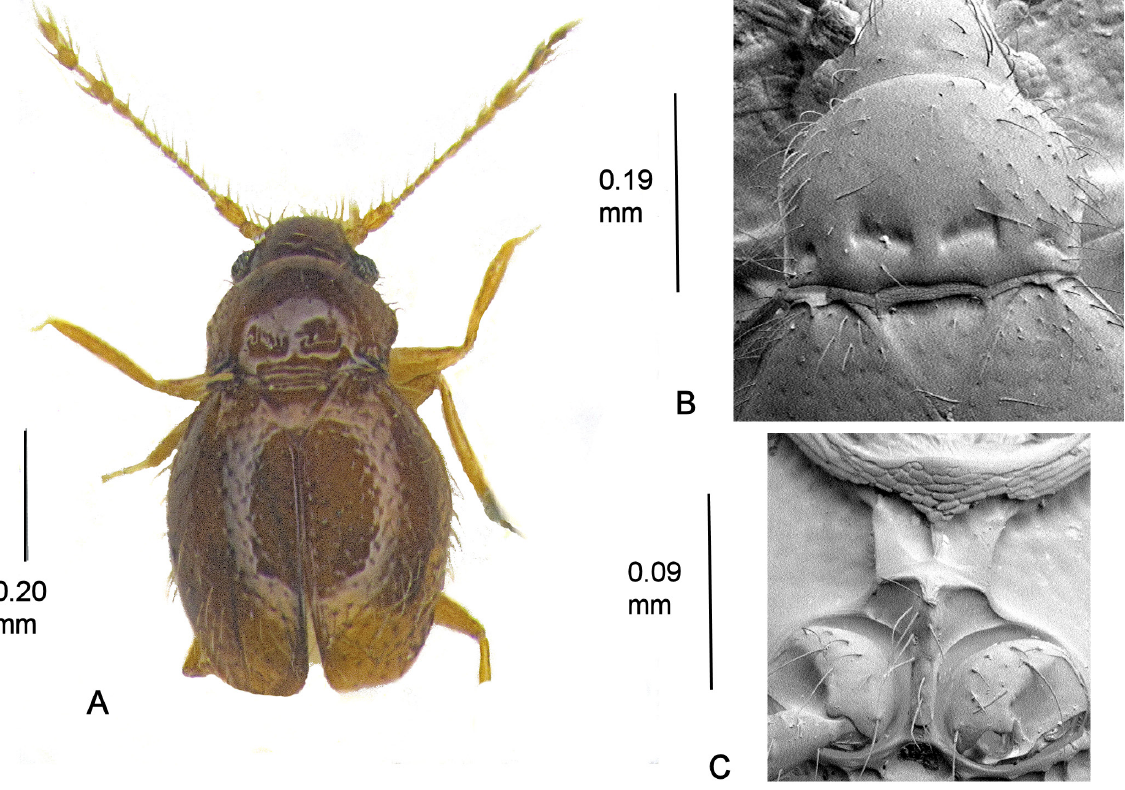
Fig. 18. Cissidium ceylonicum sp. nov. A . Habitus. B . Pronotum, × 590. C . Mesoventrite showing median process of collar, mid-keel and keel,